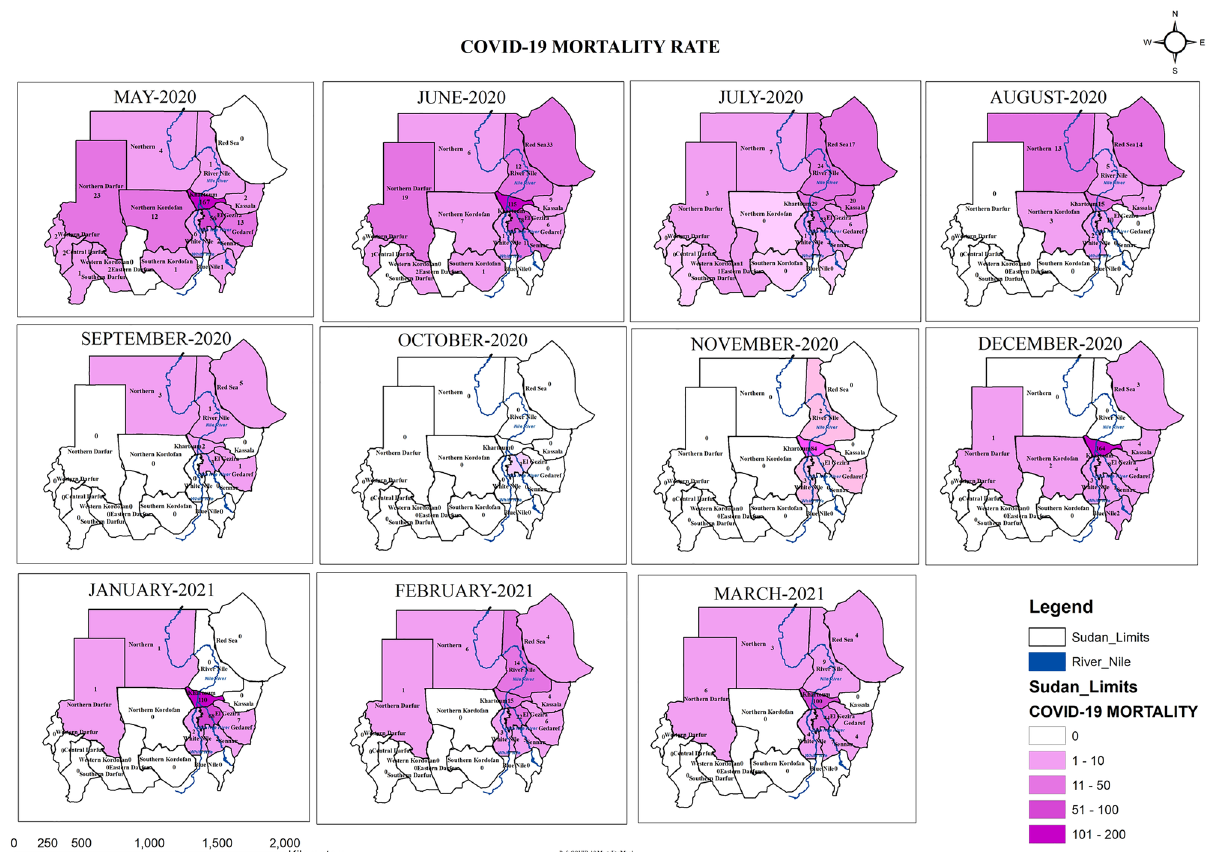
Figure 3. COVID-19 Mortality rate across the states of Sudan May 2020-March 2021 developed through ArcGIS 10.8 by Abd El-Raheem et al. (Shp. files of the base maps https:// www. diva- gis. org/